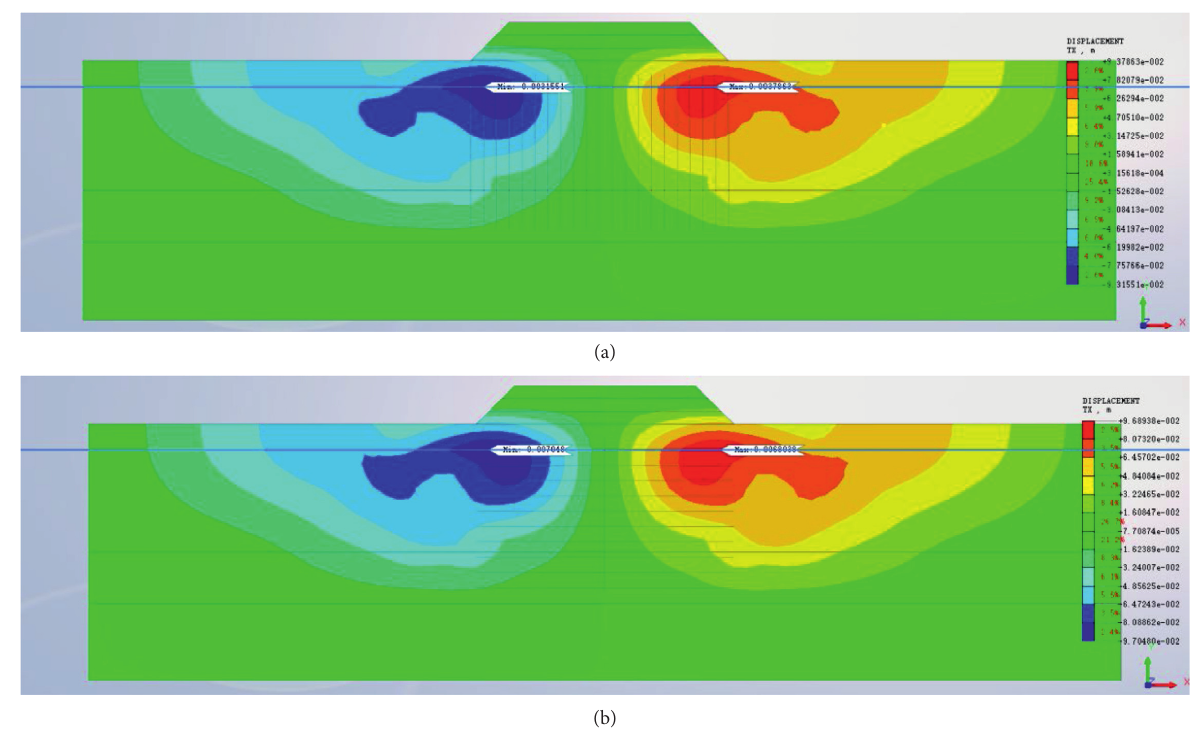
Figure 8: Cloud chart of horizontal displacement calculation: (a) PVDs and (b) PHDs.